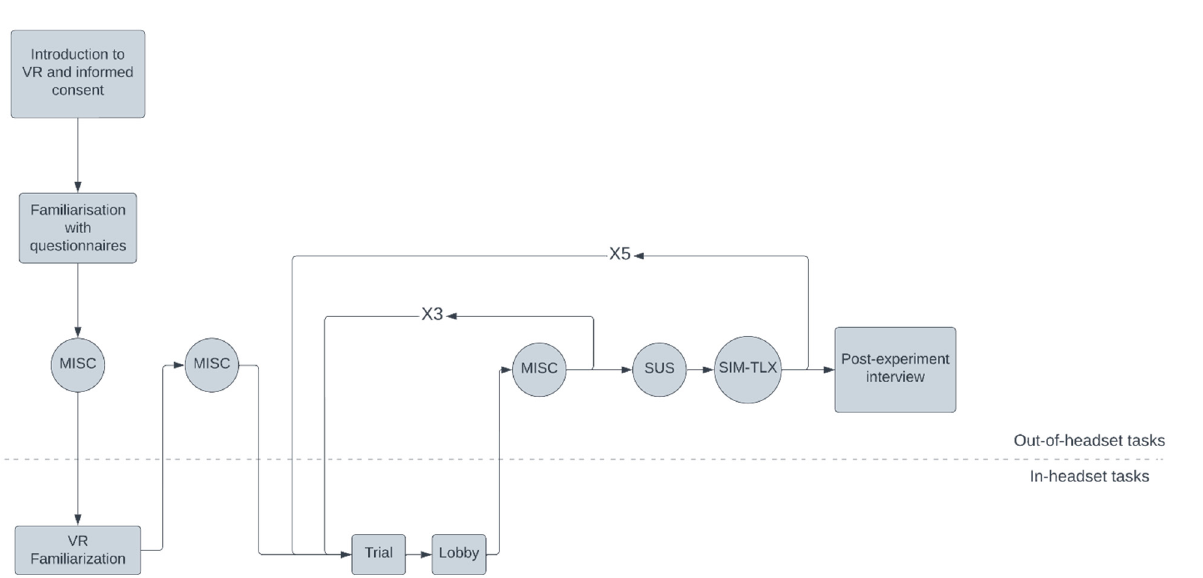
Figure 6. Schematic overview of the study procedure. Participants were first introduced to the study and given some time to familiarise with the questionnaires and with the VR after a first Misery Scale (MISC) measurement was collected. Following the familiarisation, participants underwent fifteen trials in blocks of three, after which presence and workload were measured with the Slater-Usoh-Steet (SUS) questionnaire and the simulation task load index (SIM-TLX) questionnaire, respectively. MISC measurements were collected after each trial. Semi-structured interviews closed the session.